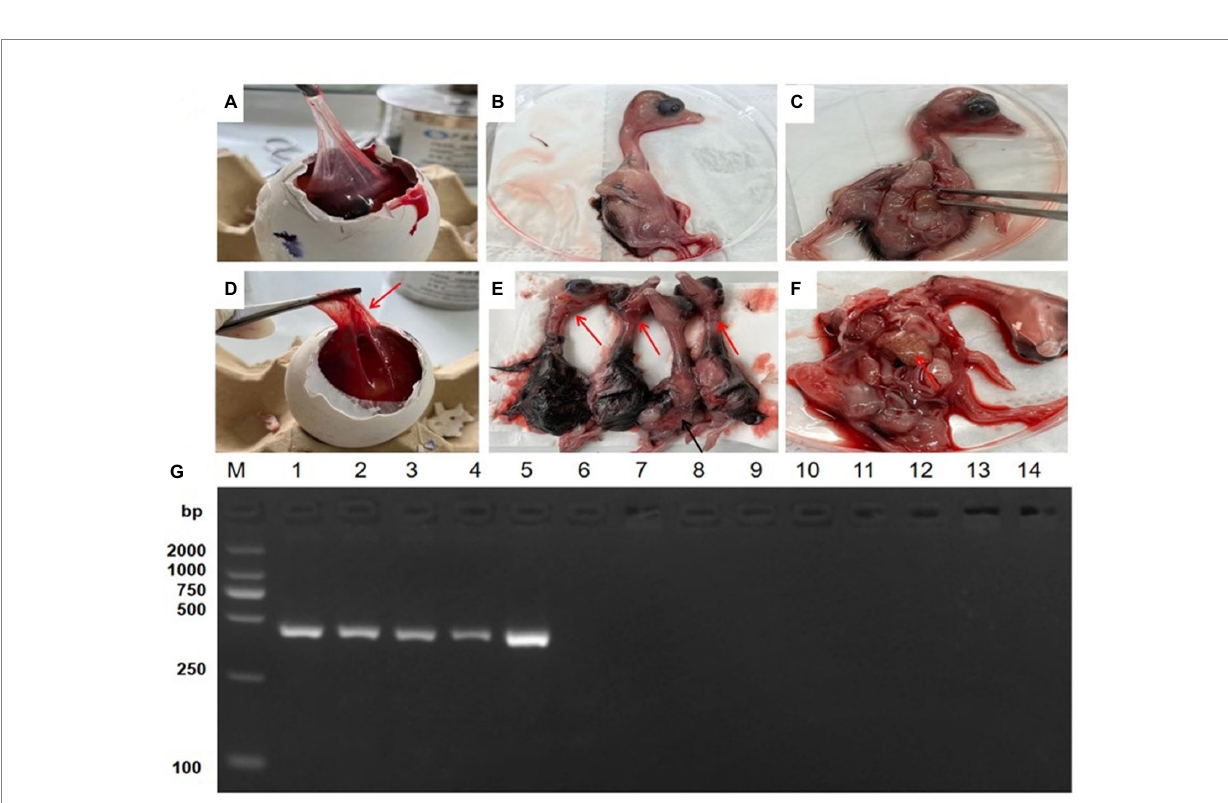
FIGURE 2 Isolation and identification of GoAstV isolates. (A–C) Healthy goose embryo control. (D) Infected embryos with a thick allantoic membrane. (E) Severe hemorrhages throughout the body. (F) Mottled necrotic foci in the infected embryo liver. (G) PCR identification of isolates from the allantoic membrane homogenate. M.2000 Marker; 1. GoAstV-GD2101; 2. GoAstV-GD2102; 3. GoAstV-GD2103; 4. GoAstV-GD2104; 5. GoAstV-GD2105; 6. GPV; 7. NDV; 8. ARV; 9. GPOV; 10. GoCV; 11. AIV (H5); 12. AIV (H7); 13. AIV (H9); 14.